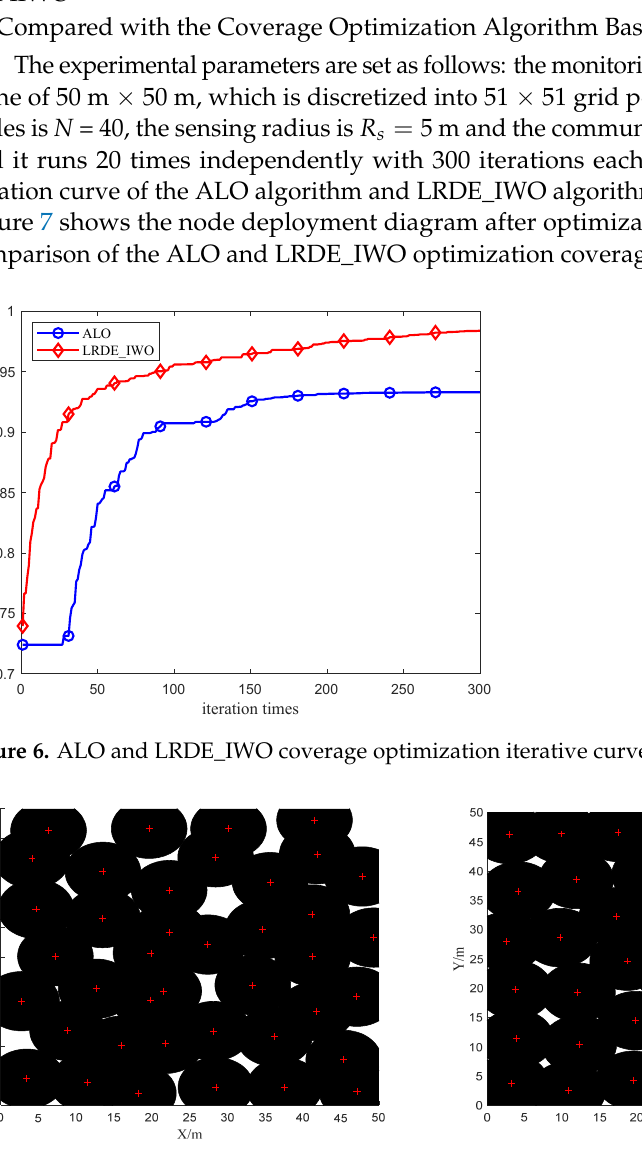
Figure 6. ALO and LRDE_IWO coverage optimization iterative curve.